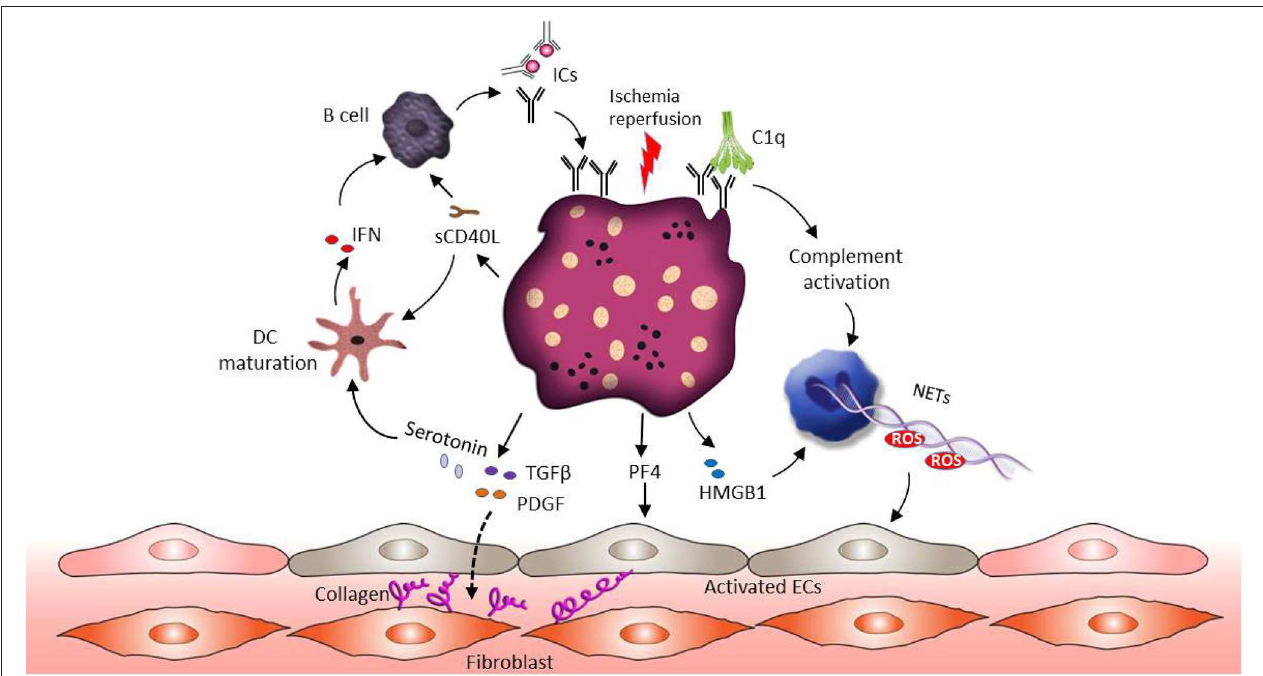
FIGURE 3 | The role of platelets in SSc pathophysiology. Ischemia-reperfusion injury associated endothelial cell damage induces platelet activation. Similar to SLE, the presence of ICs could promote hypersensitivity of platelets and complement activation. Activated platelets release their profibrotic mediators such as TGF- β , serotonin and PDGF, and these factors stimulate connective tissue fibroblasts proliferation and increase collagen production. In addition, both HMGB1 released from platelets and complement activation can support NET formation and ROS release, which further mediates vascular endothelial dysfunction. Apart from NETs, platelets derived PF4 activates endothelial cells and induces SSc associated vascular damage. Activated platelets also release sCD40L to active B cells through CD40 signaling, which leads to B cell auto-antibody production. Moreover, sCD40L and serotonin can promote the maturation of myeloid DCs, followed by IFN production and further B cell